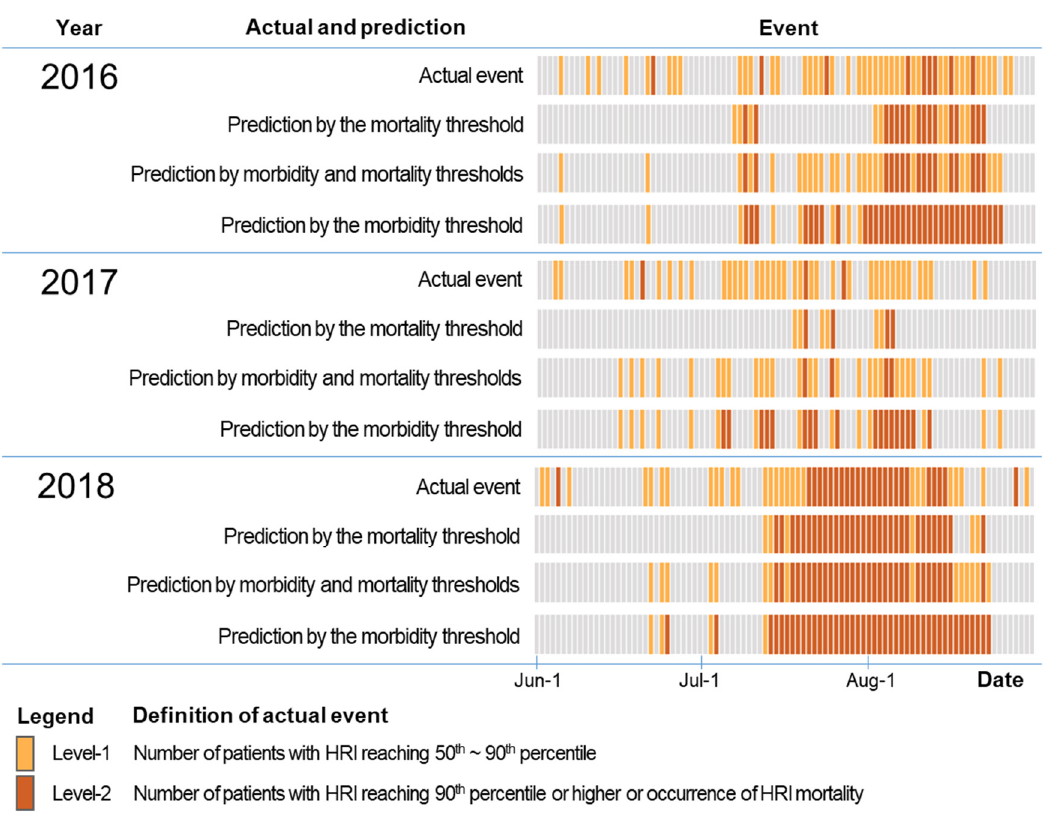
Figure 6. Comparison of actual and predicted heat-related illness (HRI) events: the actual event was based on monitoring data in the emergency department of the hospital; predicted events were determined according to types of the threshold.